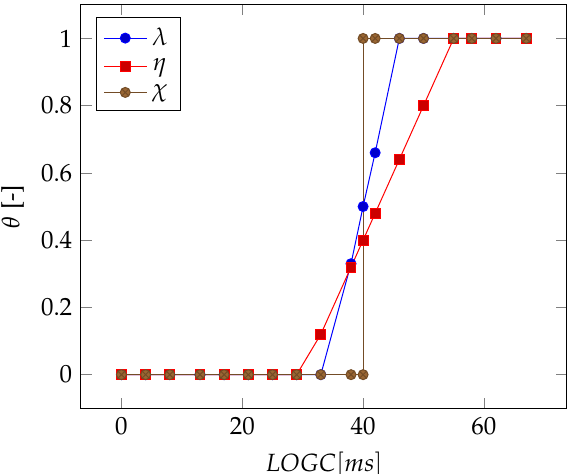
Figure 8. Membership functions for the inertial sensor ( η ) and the video benchmark system ( λ ). χ is the graphical representation of the binary classification. θ represents the output values of the